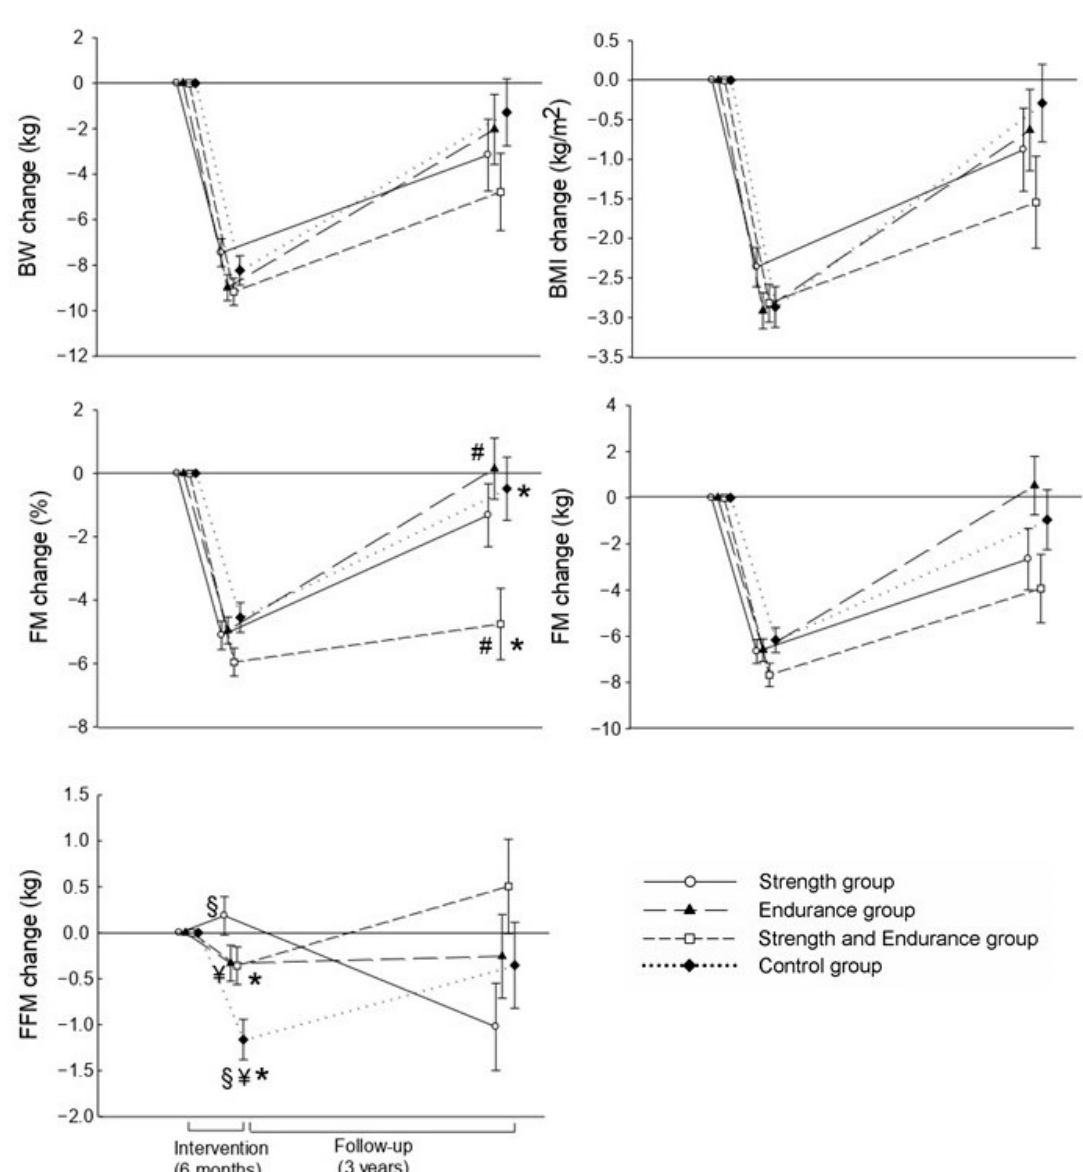
Figure 2. Body composition changes between post-intervention and pre-intervention (6 months’ intervention) and 3 years after intervention and post-intervention (3 years’ follow-up), adjusted by sex, age, and the corresponding baseline value of the study outcome. Common superscripts indicate a significant difference between groups (all p ≤ 0.05). BW: body weight; BMI: body mass index; FM: fat mass; FFM: fat-free mass.